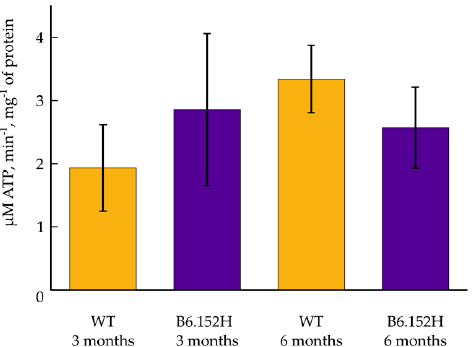
Figure 4. Measurements of the F1F0 ATP-synthase activity in isolated brain mitochondria. Quantification of the amount of ATP hydrolyzed per minute per mg of mitochondrial protein extracted from the forebrain of WT and B6.152H mice of 3 and 6 months of age. Mean of multiple probing from at least three independent mitochondria preparation for each genotype and for each age. For p ≤ 0.05, the differences among phenotypes were not statistically significant. Columns represent mean value plus/minus SEM.